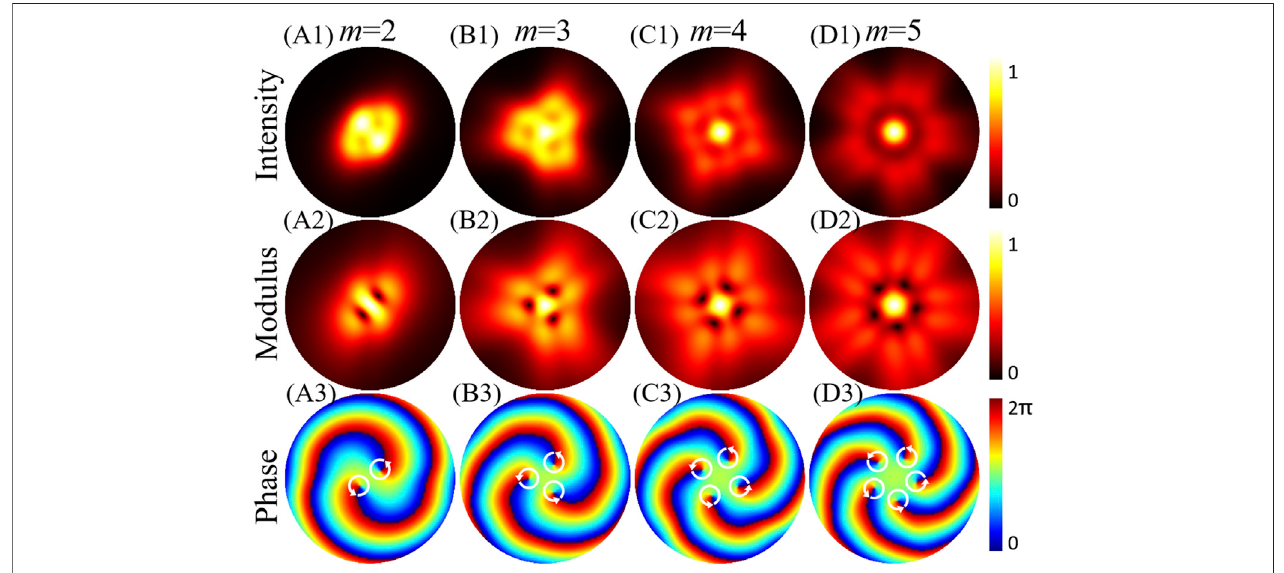
FIGURE 5 | Numerical simulation intensities and CSD distributions of the PC-PEPV beams on the focal plane with medium spatial coherence equal to the beam waist ( σ (cid:1) 1 mm) and power order n (cid:1) 2. (A1 – D1) are the intensity patterns, (A2 – D2) are the modulus of the CSD function, and (A3 – D3) are the phase patterns of the CSD function. White circular arrows represent the anticlockwise direction of the phase winding which indicates the positive TC.